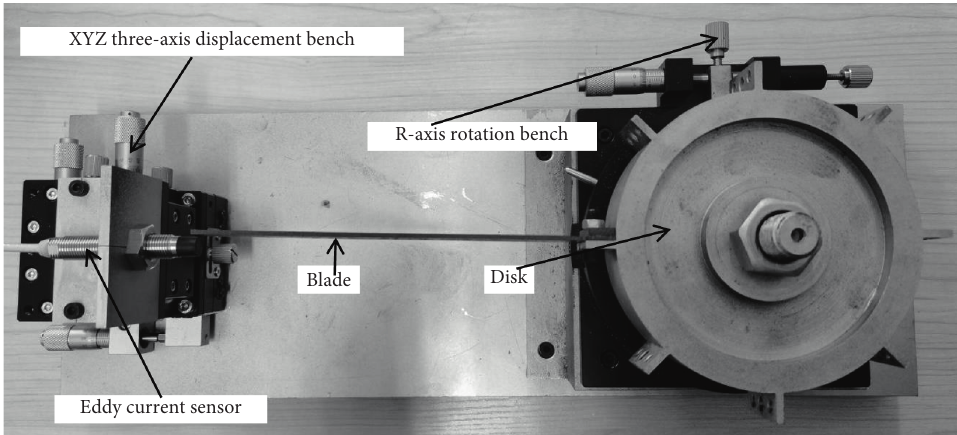
Figure 3: Static calibration system experimental device.